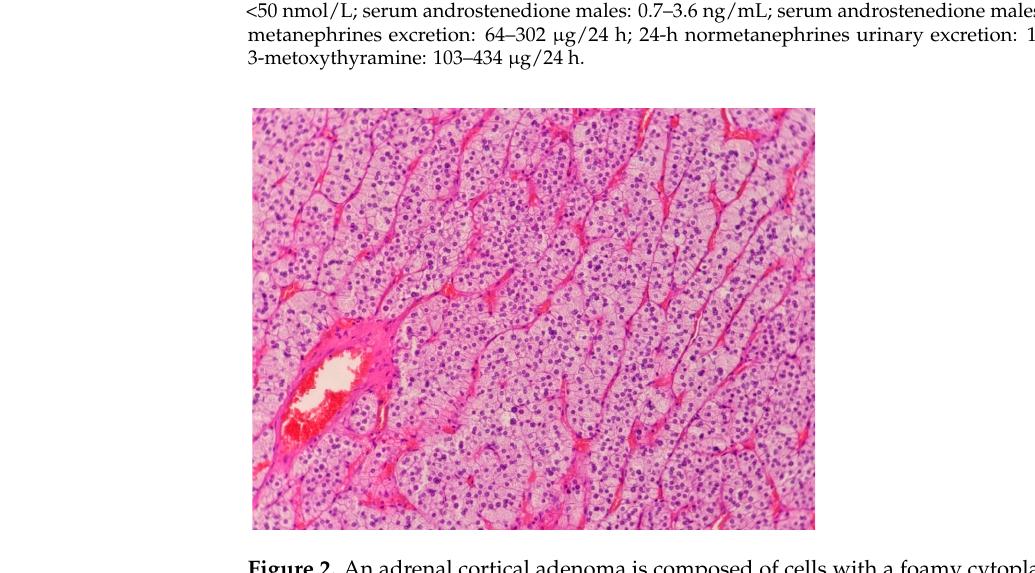
Figure 2. An adrenal cortical adenoma is composed of cells with a foamy cytoplasm, which is rich in lipids, and resembles cells of the zona fasciculata of the adrenal cortex. Table 1. Patient’s hormonal activity characteristics.